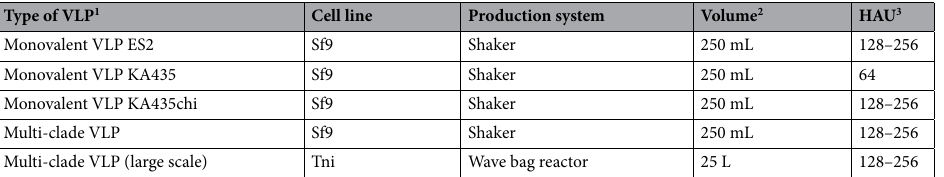
Table 1. Expression and proliferation of VLPs. HAU hemagglutination units, VLP virus-like particle. 1 VLPs were purified from Sf9 or the Tni culture supernatant. 2 Volume of the cell culture supernatant. 3 Hemagglutination activity was determined using 1% chicken red blood cells.